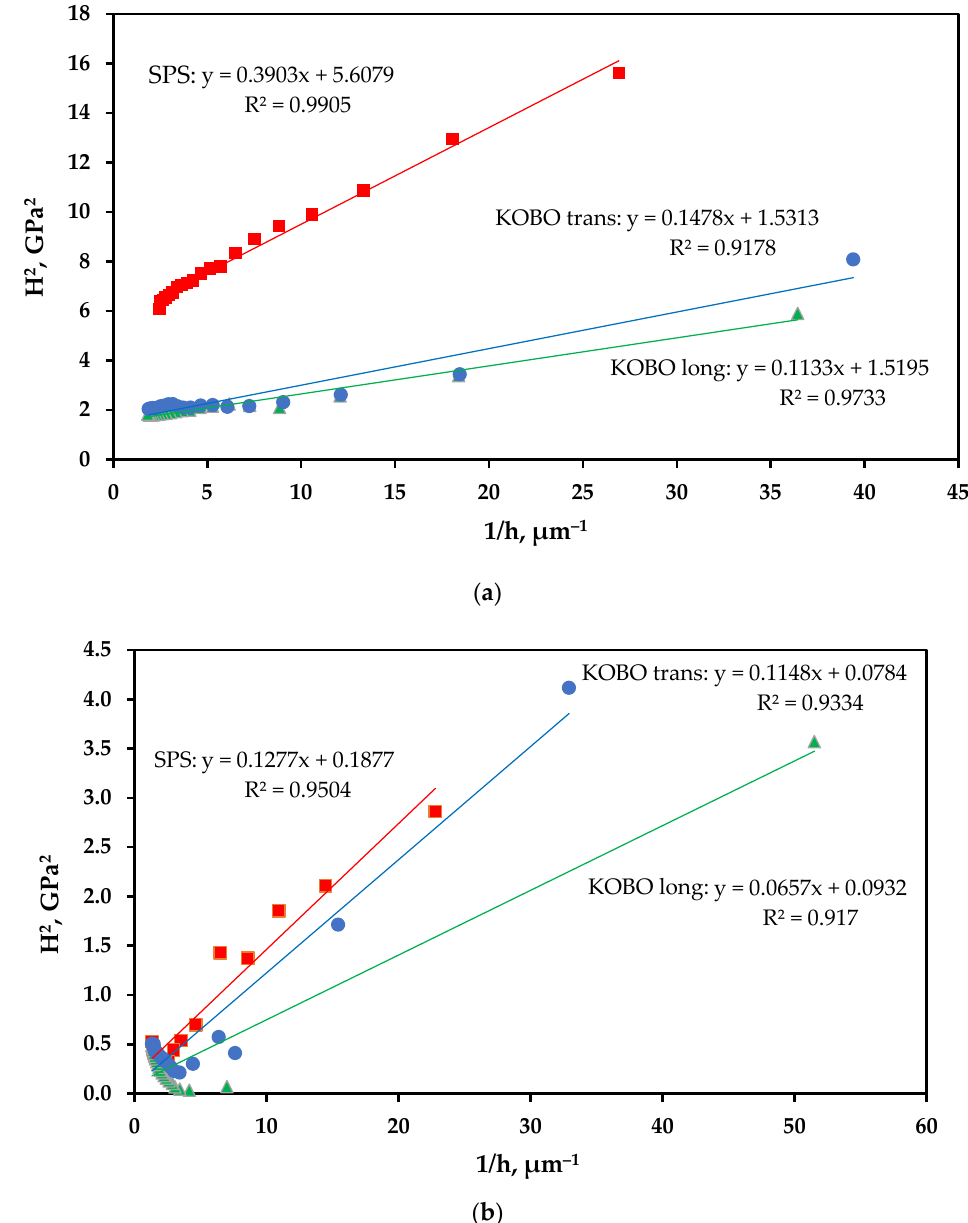
Figure 13. H 2 = f(1/h) functions and their linear approximation for coarse ( a ) and fine ( b ) grains. KOBO trans—transverse cross-section; KOBO long—longitudinal cross-section.